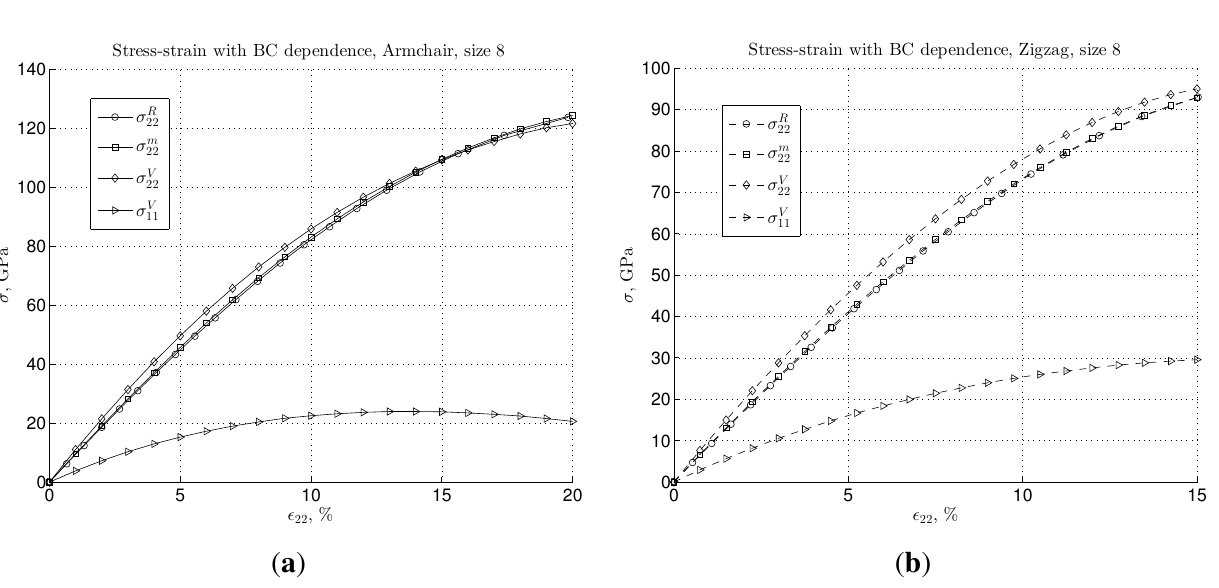
Figure 6. Stress-strain dependence for large strain using the Morse interatomic potential for ( a ) armchair and ( b ) zigzag graphene samples of a size of